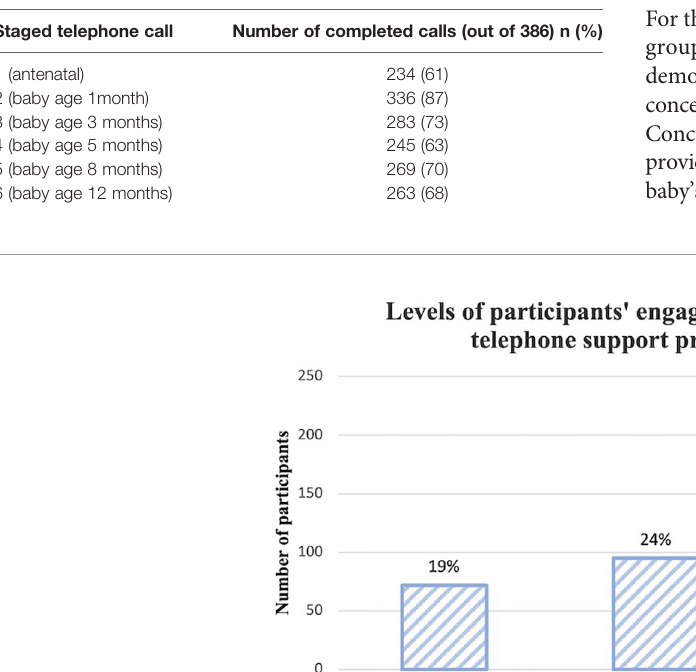
TABLE 1 | Number of completed telephone calls for each stage of intervention.